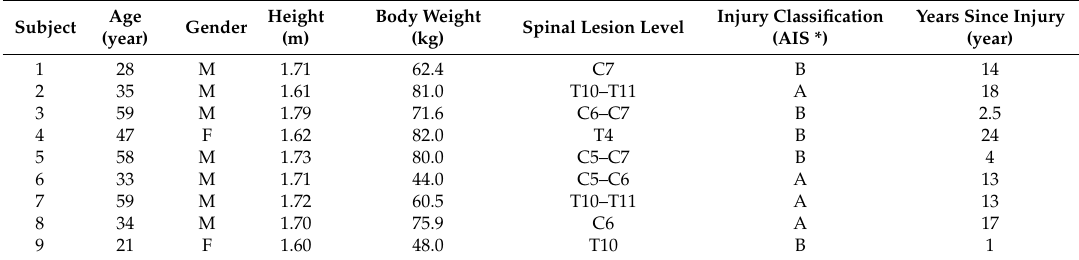
Table 1. Physical Characteristics of SCI study